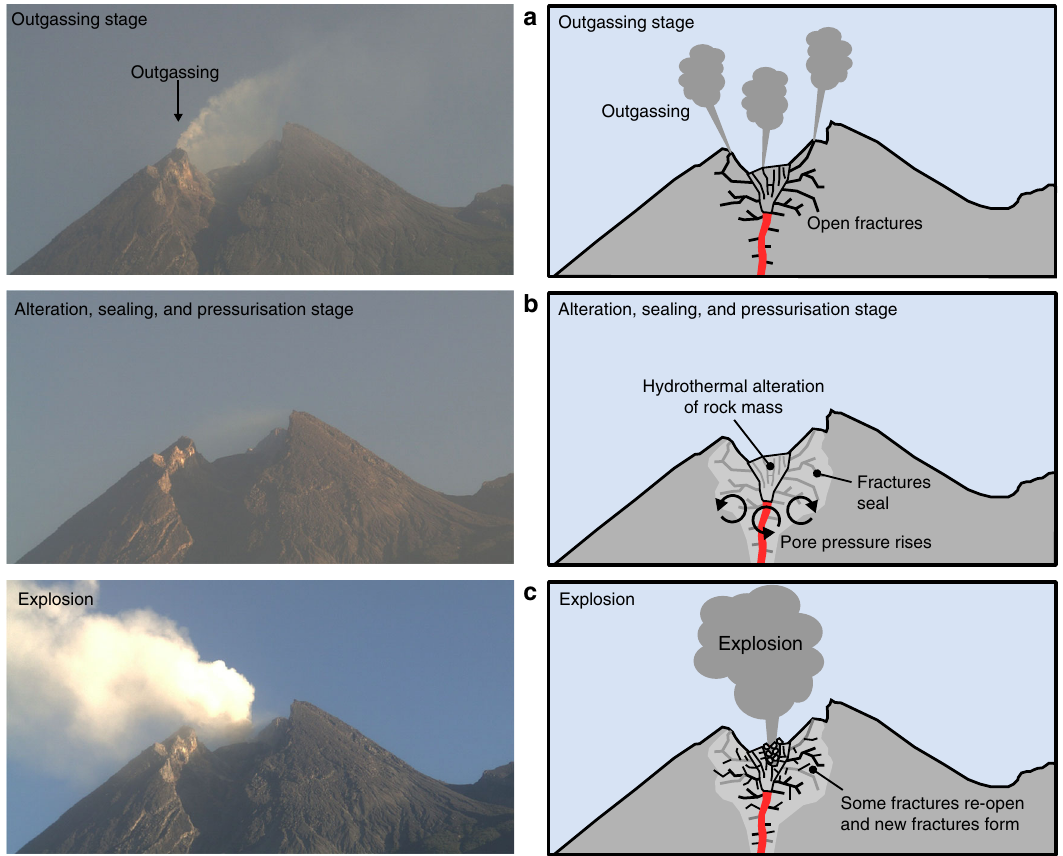
Fig. 4 Explosive behaviour at Merapi volcano thought to be prompted by hydrothermal alteration. a The outgassing stage. Photograph of Merapi on May 3 showing focused outgassing on the dome rim. We interpret this as the result of outgassing through open fractures. b Alteration, sealing, and pressurisation stage. Focussed outgassing stopped on May 5 (the photograph shown here is from May 7). We interpret this as the result of the hydrothermal alteration of the dome (alteration of the rock mass and sealing of fractures). This causes pore pressure to rise beneath the dome. c Explosion. After 5 days of no to little outgassing, an explosion occurred on May 11. The explosion is interpreted as a consequence of the pore pressure augmentation beneath the dome. Some fractures are re-opened and new fractures form allowing for passive outgassing following the explosion (as shown in Supplementary Fig. method (for low-permeability samples). For the steady-state fl ow measurements, volumetric fl ow rate measurements (using a gas fl owmeter) were collected for several pore pressure gradients (monitored using a pressure transducer) to determine permeability using Darcy ’ s law and to check for ancillary corrections such as the Forchheimer and Klinkenberg corrections. For the pulse-decay measurements, we determined permeability, and checked for the above- mentioned corrections, using the decay of a pore pressure gradient (monitored using a pressure transducer). More details on these methods of permeability determination can be found in Heap et al. 76 .